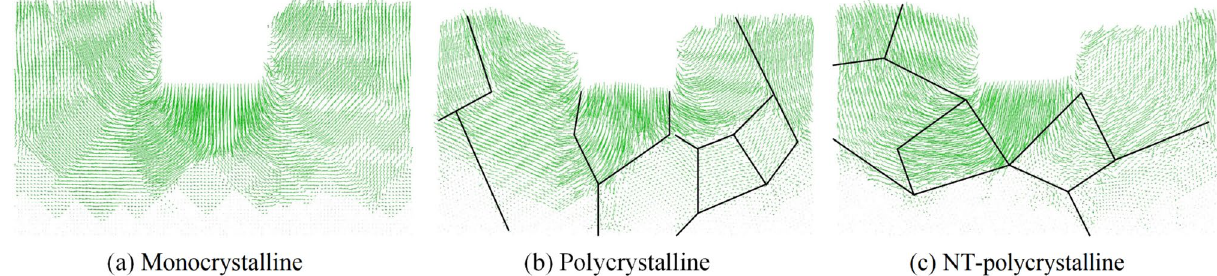
Figure 7. The cross-sectional view of the displacement vectors of atoms under the nanoimprinting at the unloading stage of the Al0.5 HEA for various crystal structures: monocrystalline ( a ); polycrystalline ( b ); and NT-polycrystalline ( c